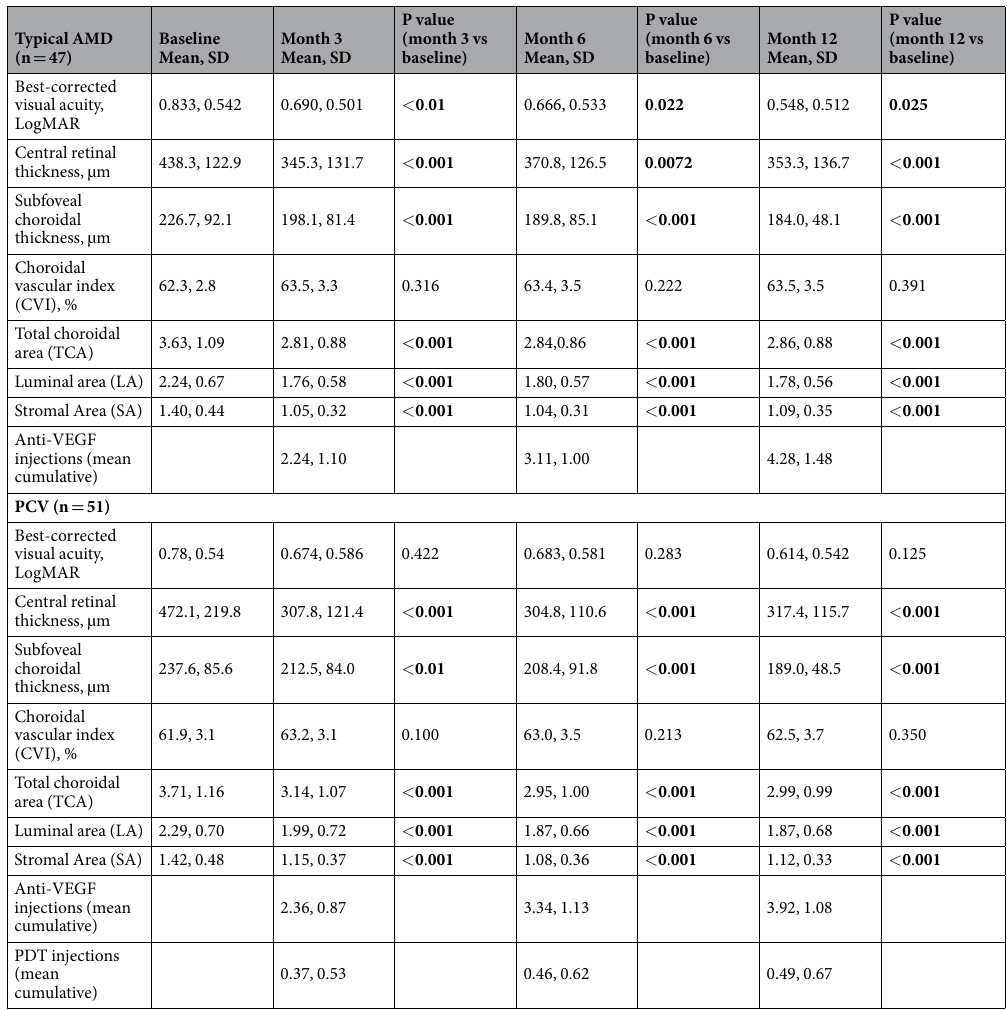
Table 2. The change in best-corrected visual acuity (BCVA), central retinal thickness, subfoveal choroidal thickness and choroidal vascularity index from baseline to month 3, 6 and 12 for eyes with typical AMD or